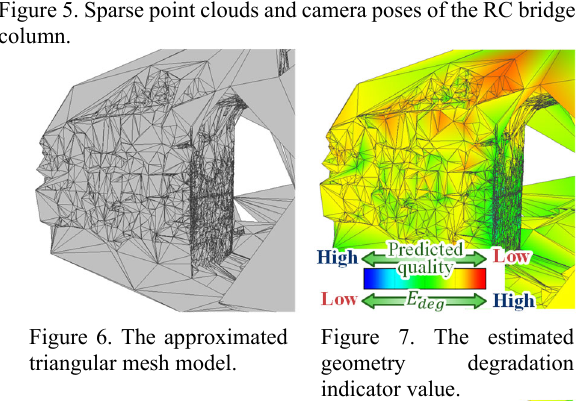
Figure 6. The approximated trian gular mesh model.